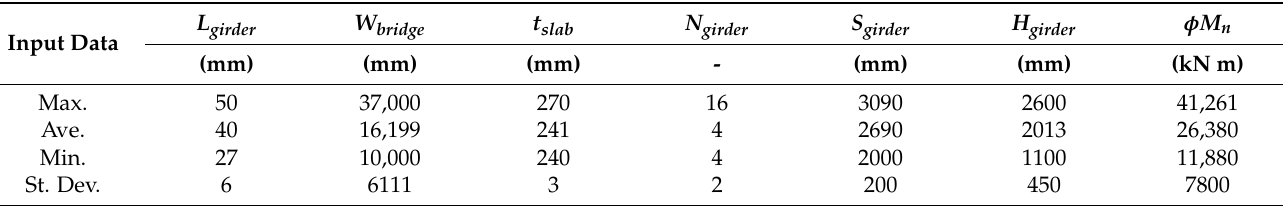
Table 1. Statical properties of bridge design document data.